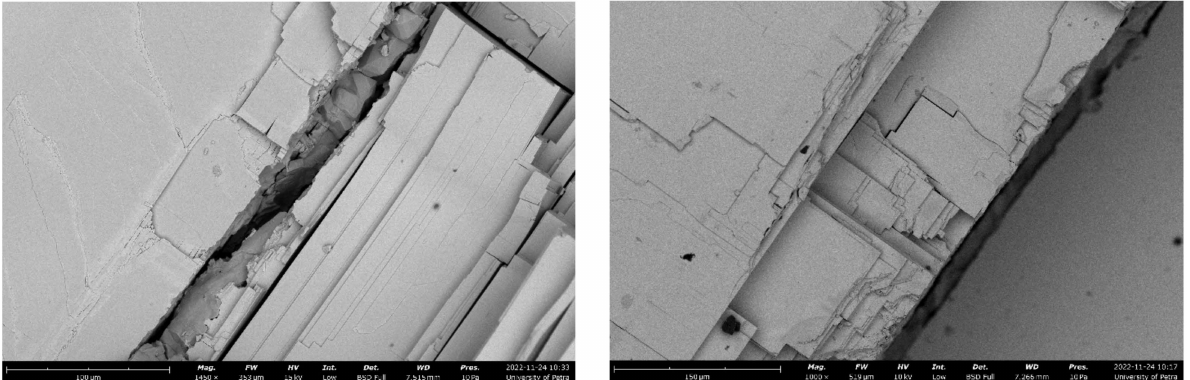
Figure 3. SEM micrographs (BSI) for different fracture surfaces of the used galena. Relevant parametes for the image on the left: scale bar: 100 um, mag: 1450 × , HV: 25 kV, Date: 24 November 2022. Relevant parametes for the image on the right: scale bar: 150 um, mag: 1000 × , HV: 10 kV, Date: 24 November 2022.